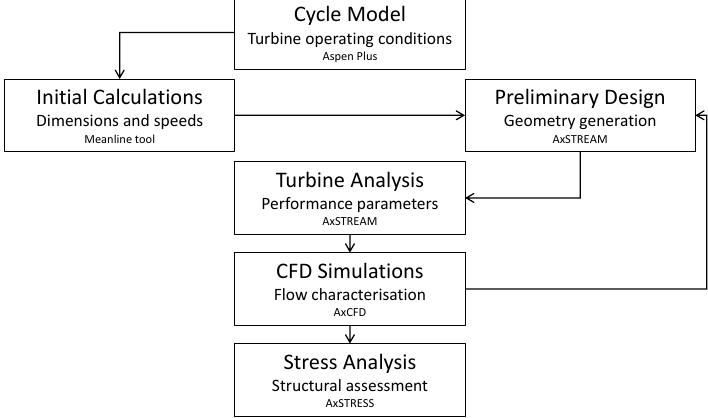
Figure 1. Overall methodology